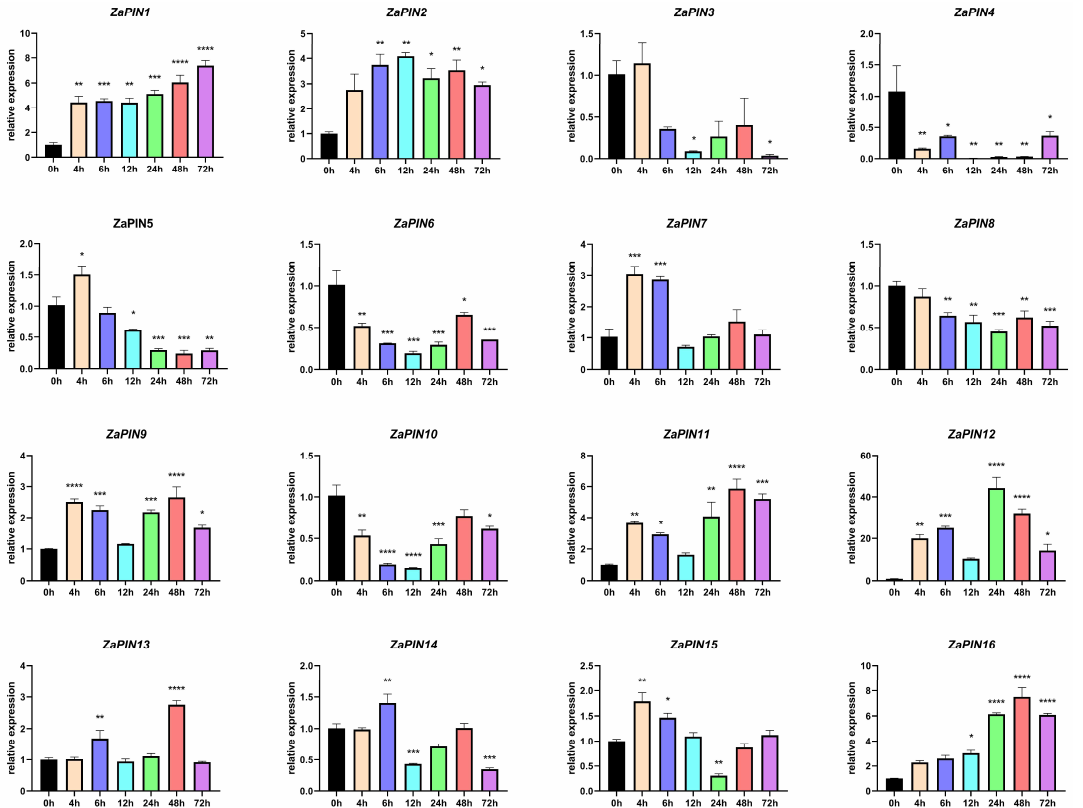
Figure 10. Relative transcript levels of ZaPINs under gibberellin (GA 3 ) treatment. Values are mean ± standard deviation based on triplicate experiments. Each time point will be compared to the 0 h group and significance will be calculated using a t -test: * indicated p < 0.05, ** indicated p < 0.01, *** indicated p < 0.001, **** indicated p < 0.0001.